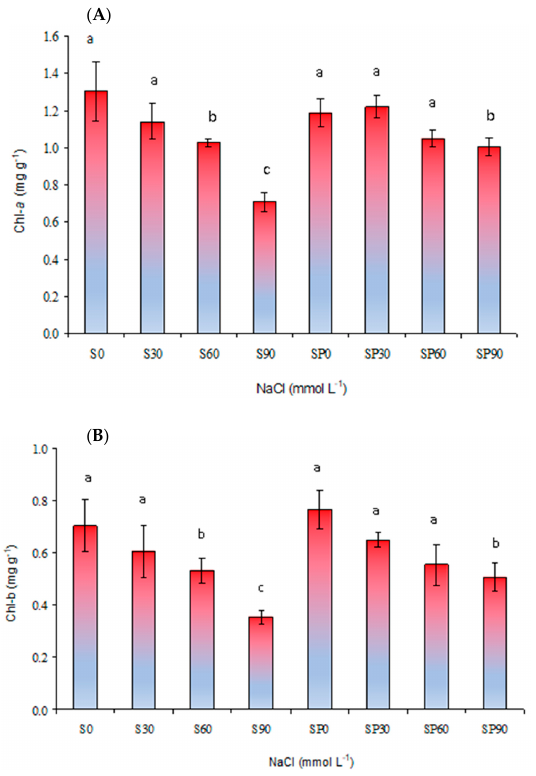
Figure 2. Leaf Chl- a ( A ) and Chl- b ( B ) contents of strawberry plants grown alone or in combination with P. oleracea at differing NaCl levels (0, 30, 60, and 90 mmol L − 1 ). S: a strawberry grown alone; SP: the strawberry and P. oleracea companionship; TSS: total soluble solids. Leaf proline content significantly increased as the concentration of NaCl levels in ‐ creased as a response to salinity stress. ( p ≤ 0.05); see Figure 3A. The highest proline level was determined as 13.77 μ mol g − 1 Fwt with the S 90 mmol L − 1 NaCl treatment, whereas at the SP 90 condition, the proline level decreased to 4.40 μ mol g − 1 . Therefore, the combination of P. oleracea not only improved the physiological and biochemical conditions of straw ‐ berry plants but also reduced the stress metabolite levels. The companionship of P. oleracea had a remarkable effect to reduce the impact of NaCl stress in strawberry plants. Again, leaf H 2 O 2 and MDA contents increased with the increasing levels of salt stress. The highest H 2 O 2 and MDA levels were determined as 74.72 and 13.58 nmol g − 1 Fwt, respectively, at the S 90 mmol L − 1 NaCl level. The co ‐ cultivation of P. oleracea with strawberry plants reduced the contents of H 2 O 2 and MDA levels down to 31.56 and 4.15 nmol g − 1 Fwt, respectively (Figure 3B,C). POX and CAT antioxidant enzymes showed parallel patterns to those of previous parameters. The co ‐ cultivation of P. oleracea significantly decreased antioxidant enzyme levels at the 60 and 90 mmol L − 1 NaCl conditions, (Figure 3D,E).